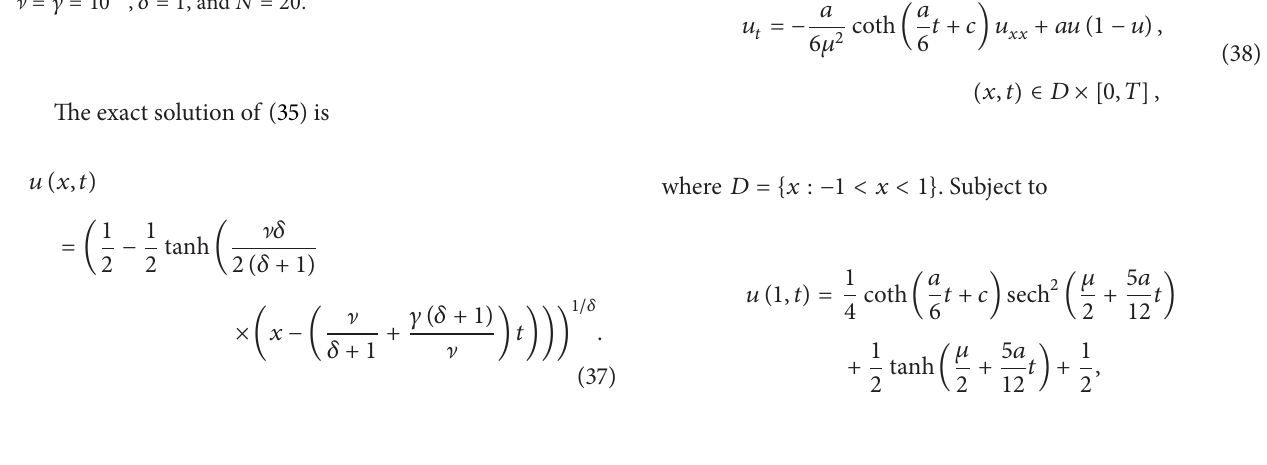
Figure 4: The curves of approximate solutions and the exact solutions of problem (35) at 𝑡 = 0.0 , 𝑡 = 0.5 , and 𝑡 = 0.9 with ] = 𝛾 = 10 −2 , 𝛿 = 1 , and 𝑁 = 20 .